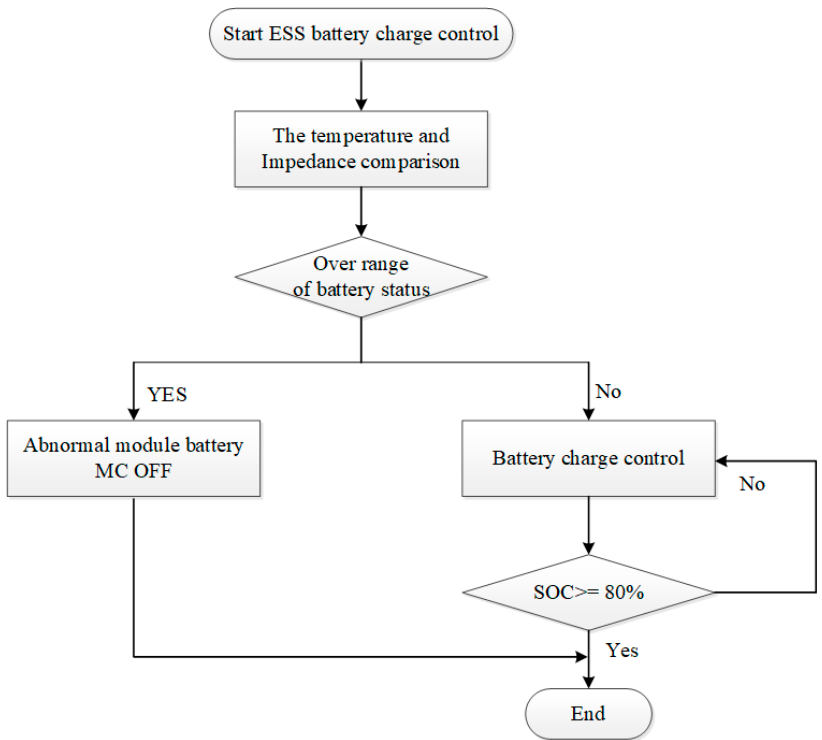
Figure 10. Fault diagnosis algorithm for ESS.